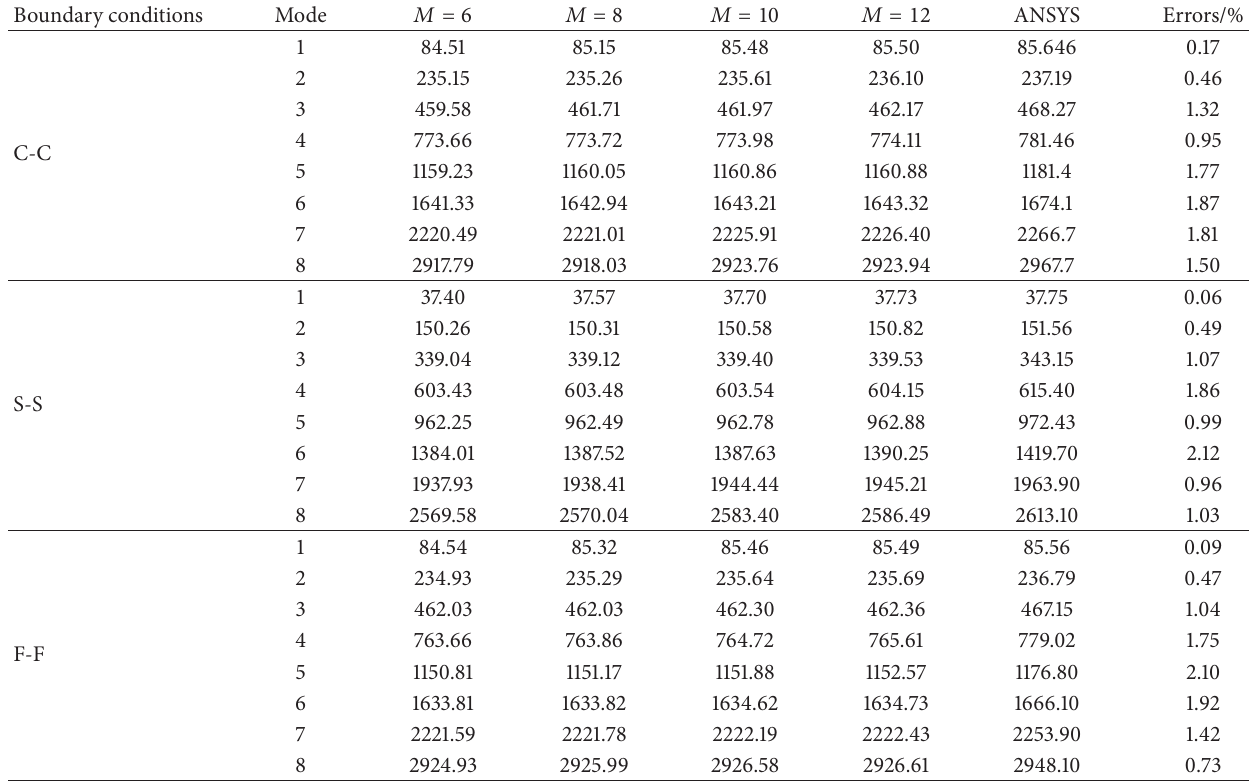
Table 3: The natural frequency for coupled beams with various boundary condition f/Hz.